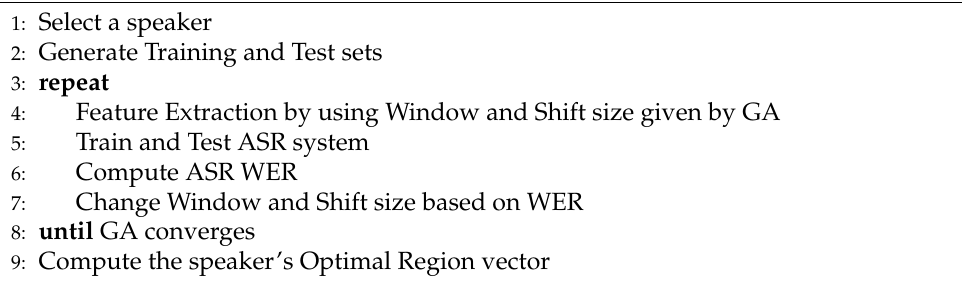
Algorithm 2 Experiment process